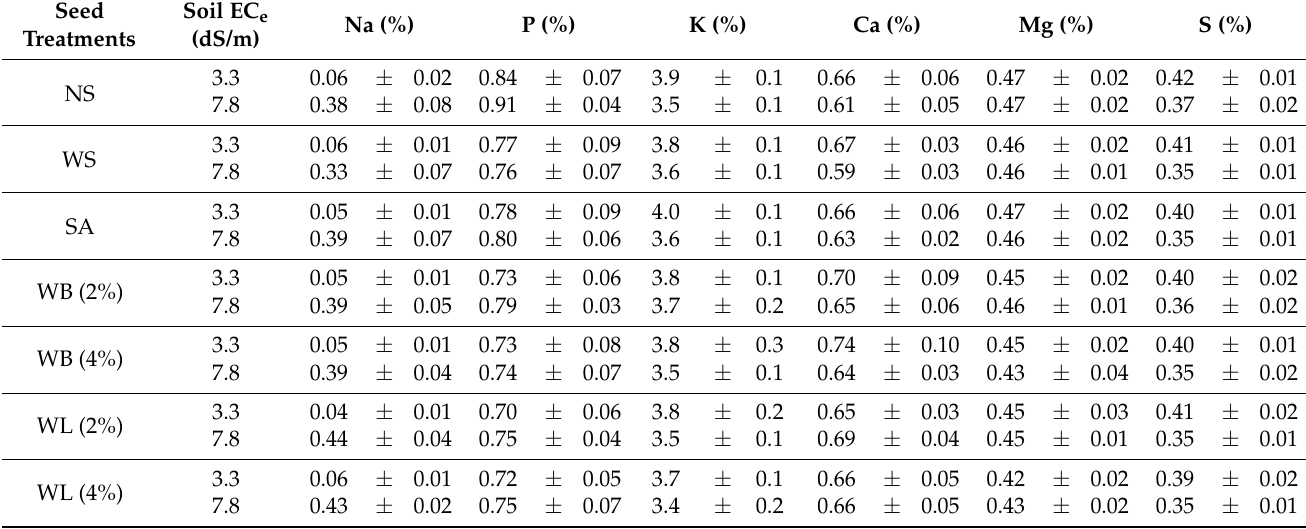
Table 4. Changes in shoot Na and macronutrient (P, K, Ca, Mg, S) concentrations of 2-week-old soil-grown maize ( Zea mays cv. Caramelo) plants in response to salinity (EC e = 3.3 dS/m; EC e = 7.8 dS/m) and different seed treatments (NS, non-soaked; WS, water-soaked; SA, salicylic acid (0.5 mM); WB, willow bark extract (2% or 4% w / v ); WL, willow leaf extract (2% or 4% w / v